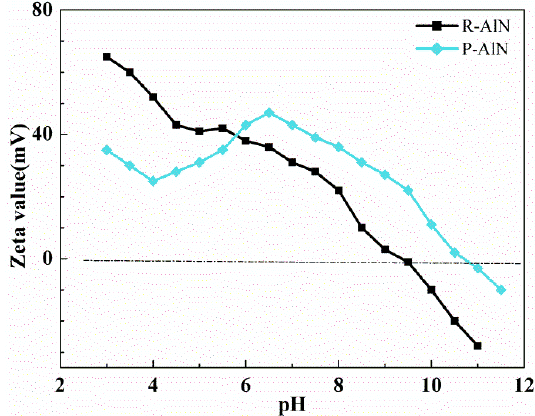
Figure 10. Zeta potential of AlN powder in different pH values. Table 3. Particle size distribution of AlN powder in water-based system. Group